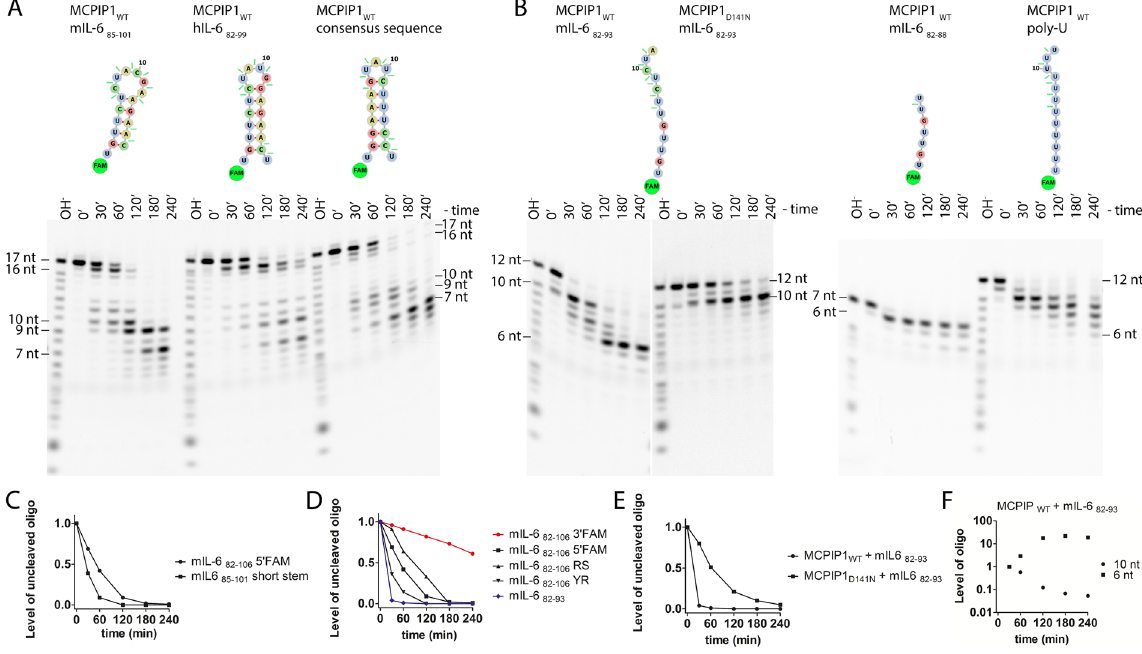
Figure 2. RNA fragments obtained upon cleavage catalyzed by MCPIP1. Major sites of MCPIP1-induced cleavage are indicated by the oligonucleotide fragment length. ( A ) Sequences and structures of the short stem- loops are depicted. These sequences form 17-18-nt-long stem-loops. ( B ) Degradation of the single-stranded RNAs. Twelve and 7-nt-long single-stranded RNA sequences were part of the mIL-6 82–106 stem-loop. Poly-U homopolymer RNA contains 12 uracil residues. The oligonucleotides were labeled at the 5 ′ end with FAM dye. The reaction products were resolved on 20% denaturing PAGE and visualized with a fluorescence imaging system. Concentrations of the labeled oligonucleotides and MCPIP1 protein were 7.5 μ M and 2 μ M, respectively. The D141N mutation of a conserved aspartate of the PIN domain catalytic center of the MCPIP1 decreased its ribonucleolytic activity. ( A , B) Were made by the separation of gels that are shown at Supplementary Fig. S2B–D. ( C ) Densitometric analysis of the level of the remaining uncleaved oligonucleotides from the RNase assay at different time points. The panel shows a comparison of the kinetics of degradation of the mIL-6 82–106 and a shorter fragment of this stem-loop, which is mIL-6 85–101 . ( D ) The panel shows the level of degradation of the 25-nt-long stem-loop mIL-6 82–106 in comparison with the 12 nt ssRNA sequence of the mIL-6 82–93 . ( E ) The graph compares the degradation of the ssRNA mIL6 82–93 with MCPIP1 WT or MCPIP1 D141N , which possesses attenuated RNase activity. ( F ) Densitometric analysis of the MCPIP1 WT induced degradation of the mIL- 6 82–93 oligonucleotide. The analysis was carried out for 6 nt and 10 nt long mIL-6 82–93 degradation products respectively, oligonucleotide levels were normalized at the time 30